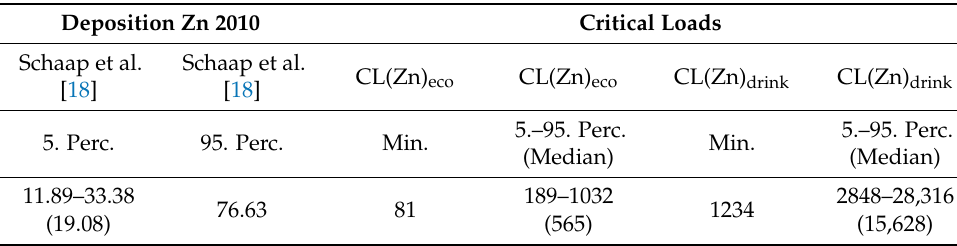
Table 11. Comparison of the Zn deposition 2010 (in g ha − 1 a − 1 ) with the critical loads (in g ha − 1 a − 1 ) of the receptor surfaces in Germany.